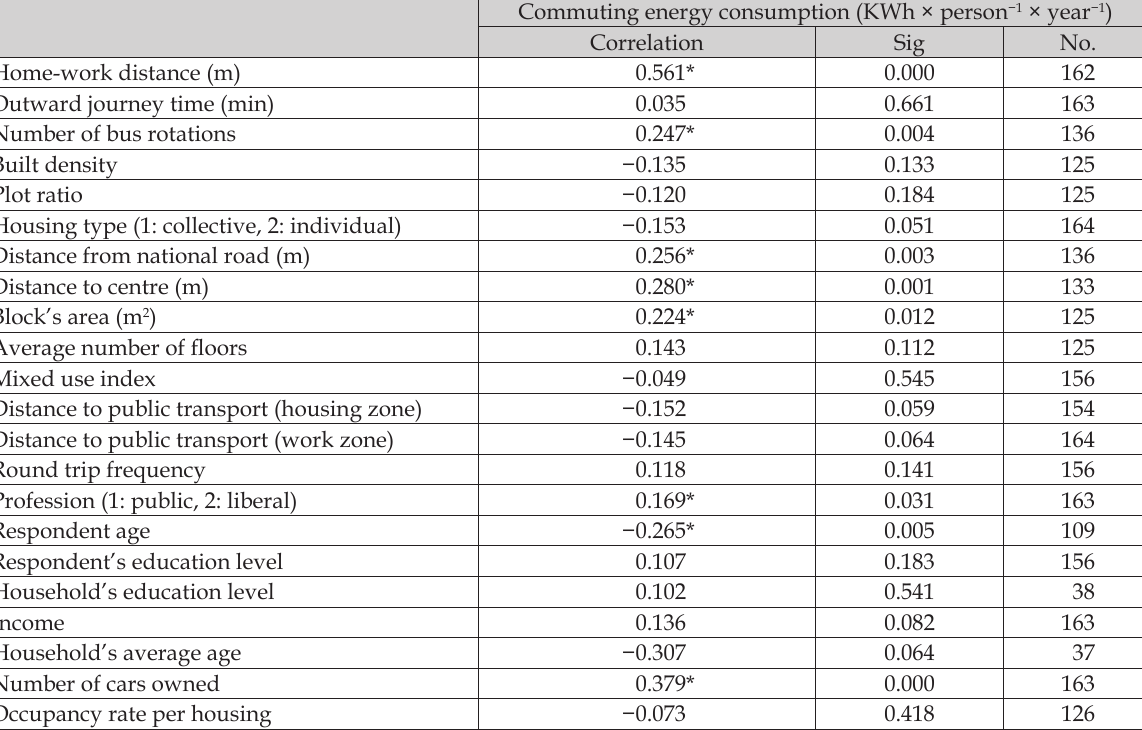
Table 1. Pearson’s bivariate correlation.